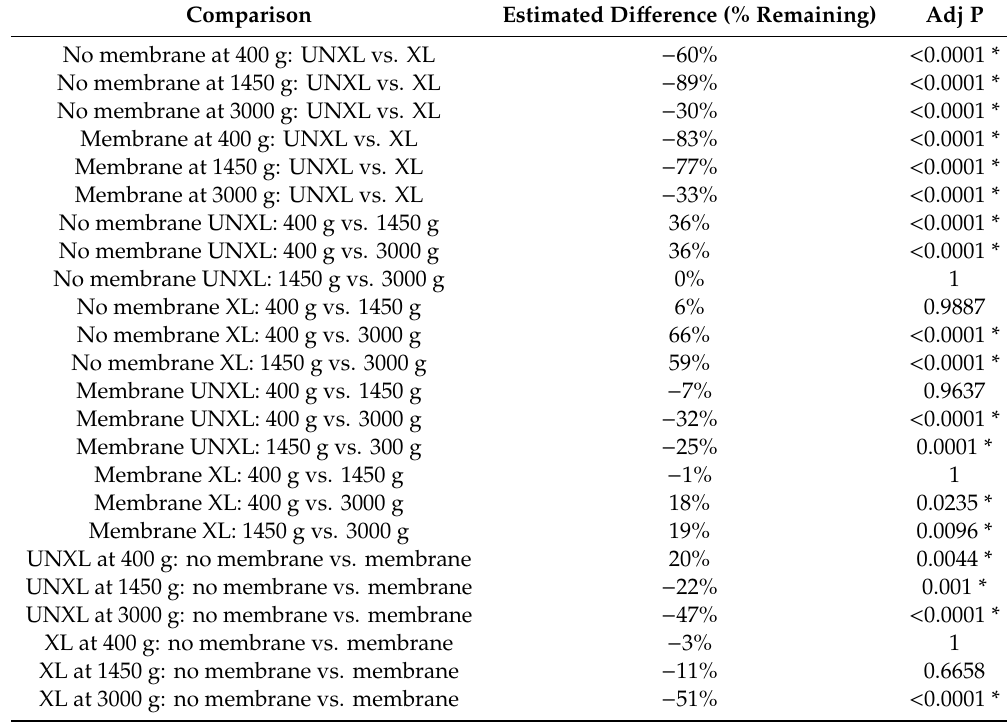
Table A2. Pairwise comparisons of % remaining for membrane, crosslinking and centrifugation rates. * indicates statistical significance ( p <